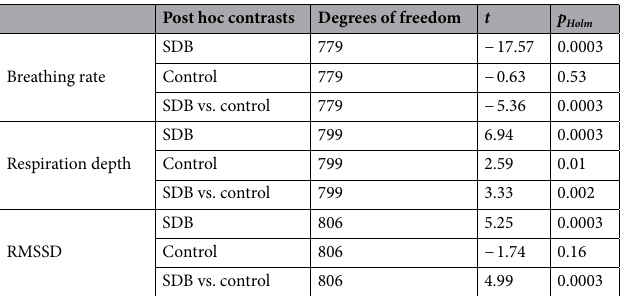
Table 2. Results of post hoc contrasts (paced-train minus pre-train periods with normal respiration) on the effects of slow deep breathing on respiration and heart rate variability. RMSSD root mean square of successive